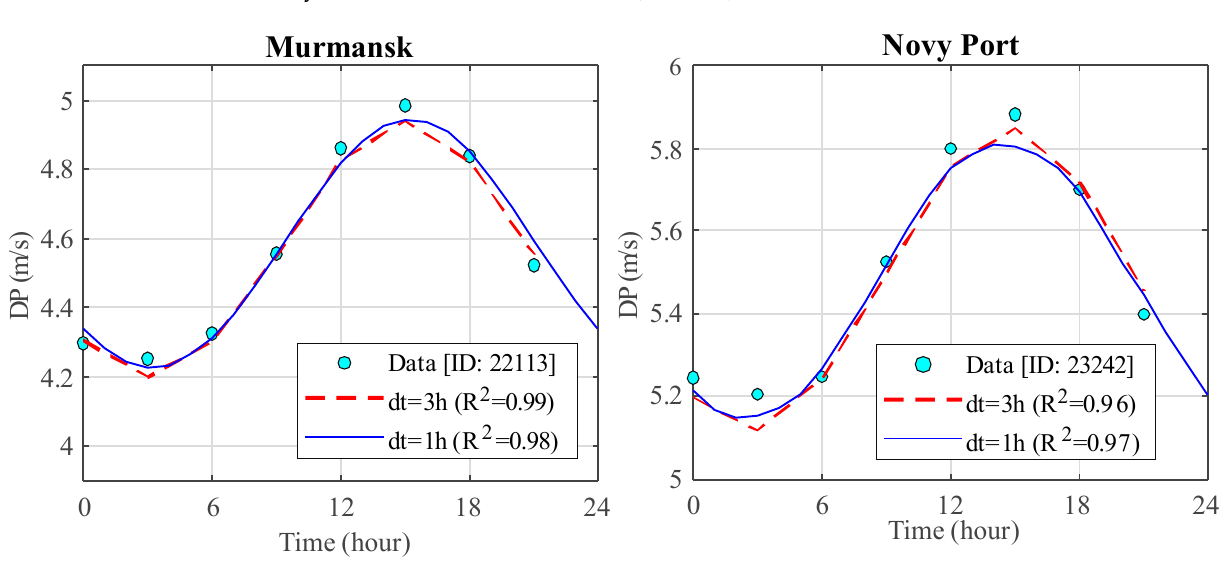
Figure 8. Daily wind speed profiles.